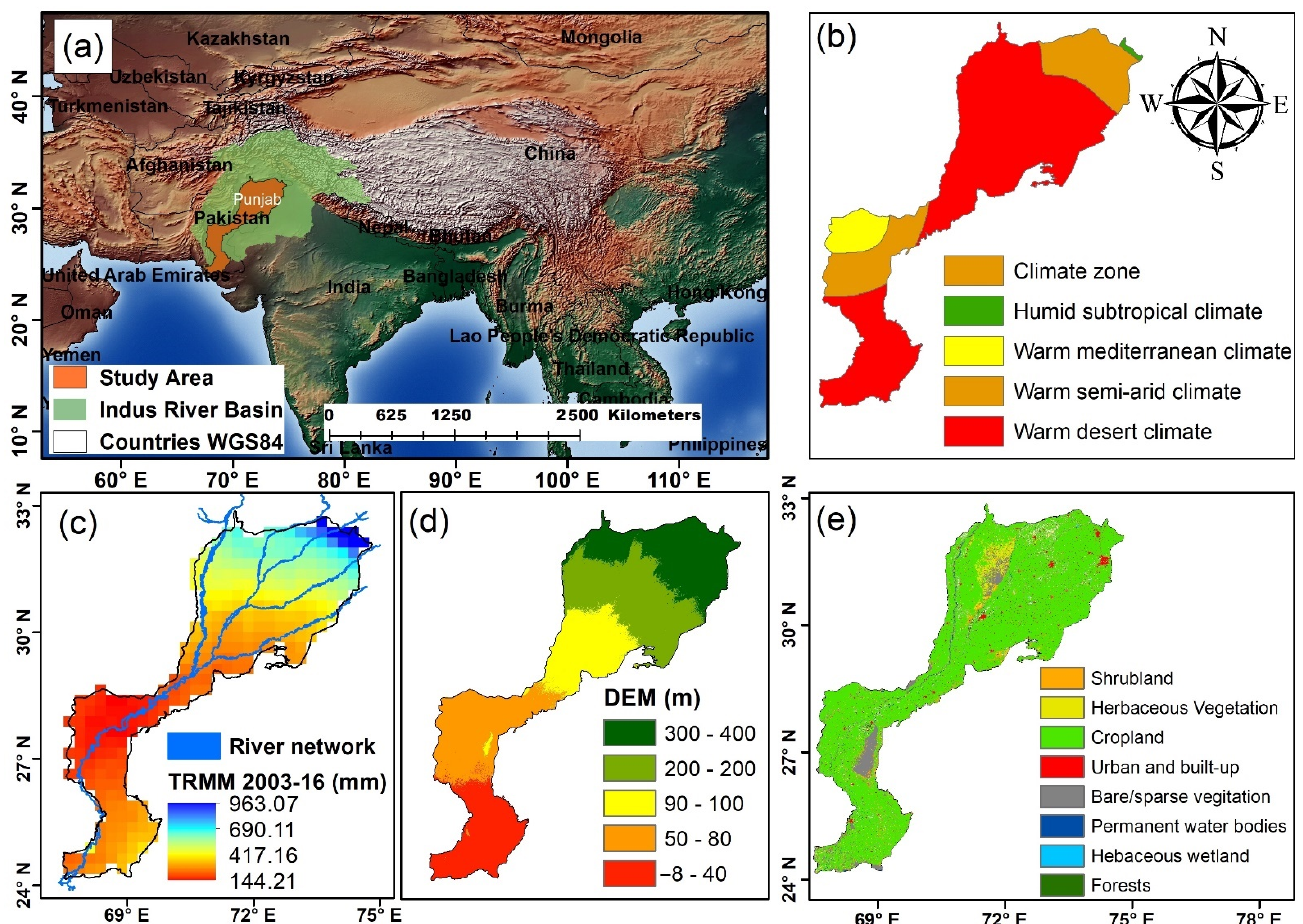
Figure 1. ( a ) The Indus River basin and the study area IBIS. The background layer contains the countries and shaded relief layers from the Natural Earth dataset (http://www.naturalearthdata.com/downloads/) accessed on 21 April 2021, ( b ) the climatic zones according to Koppen Geiger Climate Classification, ( c ) average rainfall from TRMM, ( d ) digital elevation model (90 m) derived from Shuttle Radar Topographic Mission (SRTM), ( e ) land use and land cover change for 2016 (https://lcviewer.vito.be/2016) accessed on 10 May 2021.